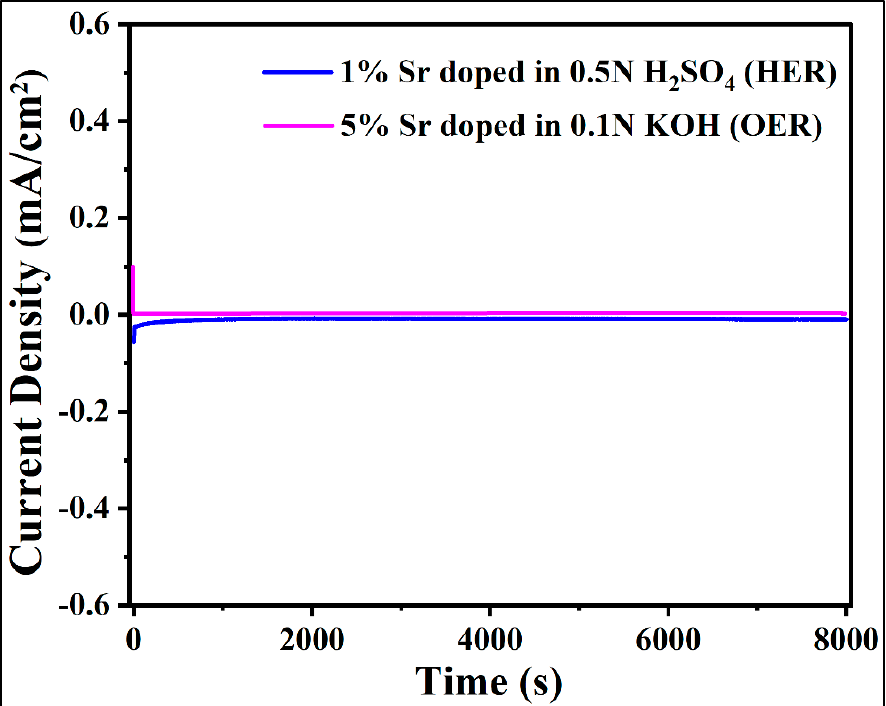
Figure 13. CA analysis at − 0.5 V and +0.5 V for 1% and 5% Sr-doped TiO 2 nanoparticles.